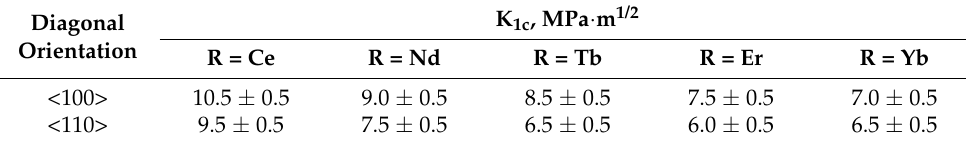
Table 5. Fracture toughness for the 2.5Y0.7RSZ crystals (R = Ce, Nd, Tb, Er,